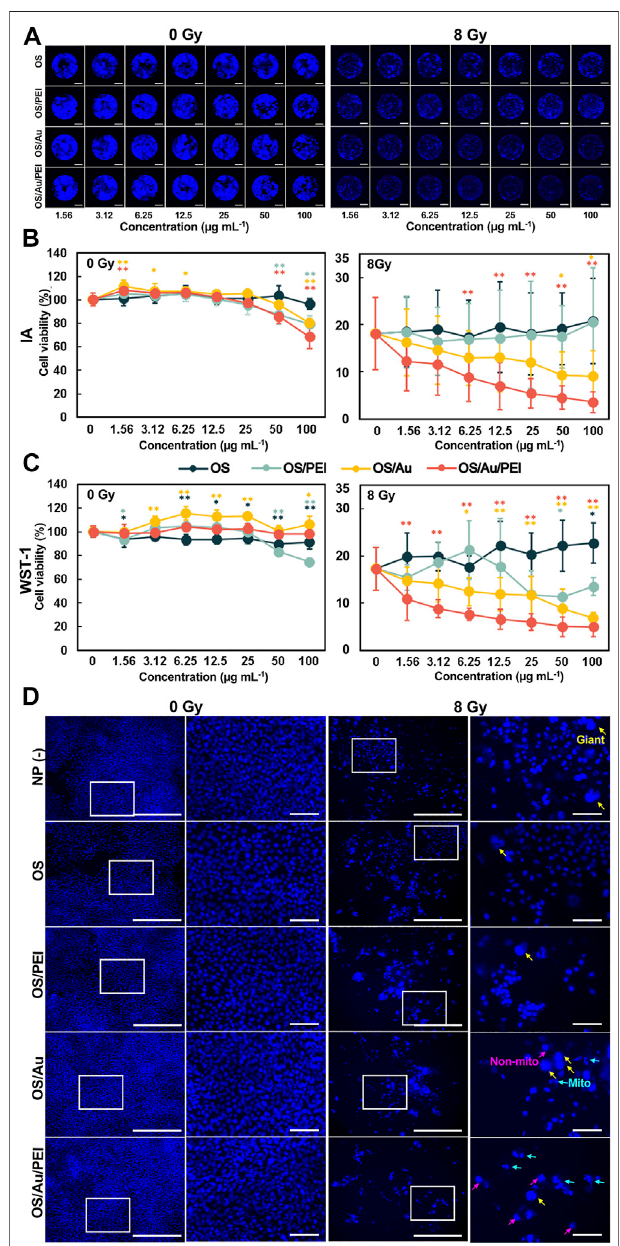
FIGURE 3 | Cell viabilities for 4T1 cells treated with various concentrations of OS, OS/PEI, OS/Au, and OS/Au/PEI as determined via the IA [ (A) ; representative imaging of FM for IA assay (Scale bar = 2 mm), and (B) ] and WST-1 assays (C) . Each value represents mean ± SD, where n = 9 (three replicates for three independent experiments). * Signi fi cantly different from the 4T1 cells treated with 0 μ g mL − 1 of NPs. (D) FM images [left (Scale bar = 500 μ m)] and high-resolution FM images [right (Scale bar = 500 μ m)] of 4T1 cells. The 4T1 cells were treated with 10 μ g mL − 1 of NP (-), OS, OS/PEI, OS/Au/PEI, and 0 and 8 Gy, respectively. Images of blue fl uorescence from Hoechst 33342 staining.